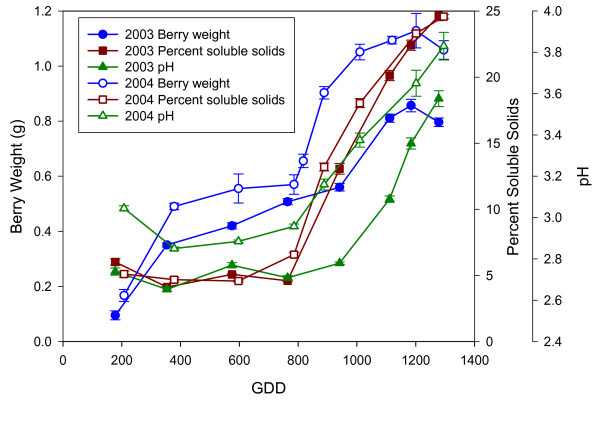
Cabernet Sauvignon berry development through the 2003 and 2004 seasons. Berry weight, soluble solids, and pH values were generated from 4 replicates of 50 berries, taken from 3 clusters each. Soluble solids were determined using a digital refractometer (PR-101, Atago, Japan) and the pH was measured on a pH meter (PHM82, Bach Simpson Ltd., London, Canada).